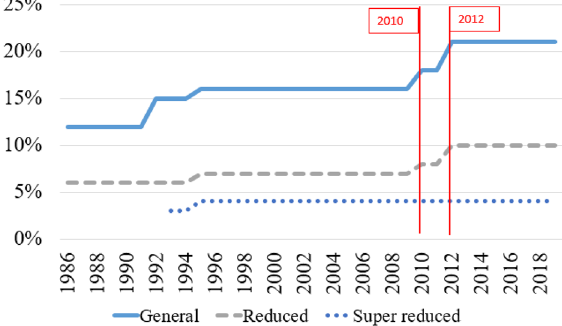
Fig. 2 Spanish VAT tax rates (1986–2019). Source : Own